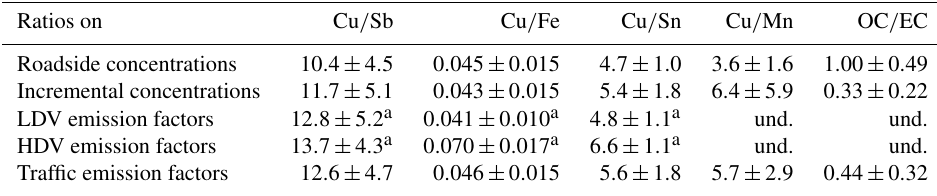
Table 5. Ratios for roadside, incremental (roadside minus urban background) concentrations, and RN87-traffic emission factors, with stan- dard deviations. Ratios on Cu / Sb Cu / Fe Cu / Sn Cu / Mn OC / EC Roadside concentrations 10 . 4 ± 4 . 5 0 . 045 ± 0 . 015 4 . 7 ± 1 . 0 3 . 6 ± 1 . 6 1 . 00 ± 0 . 49 Incremental concentrations 11 . 7 ± 5 . 1 0 . 043 ± 0 . 015 5 . 4 ± 1 . 8 6 . 4 ± 5 . 9 0 . 33 ± 0 . 22 LDV emission factors 12 . 8 ± 5 . 2 a 0 . 041 ± 0 . 010 a 4 . 8 ± 1 . 1 a und. und. HDV emission factors 13 . 7 ± 4 . 3 a 0 . 070 ± 0 . 017 a 6 . 6 ± 1 . 1 a und. und. Traffic emission factors 12 . 6 ± 4 . 7 0 . 046 ± 0 . 015 5 . 6 ± 1 . 8 5 . 7 ± 2 . 9 0 . 44 ± 0 .